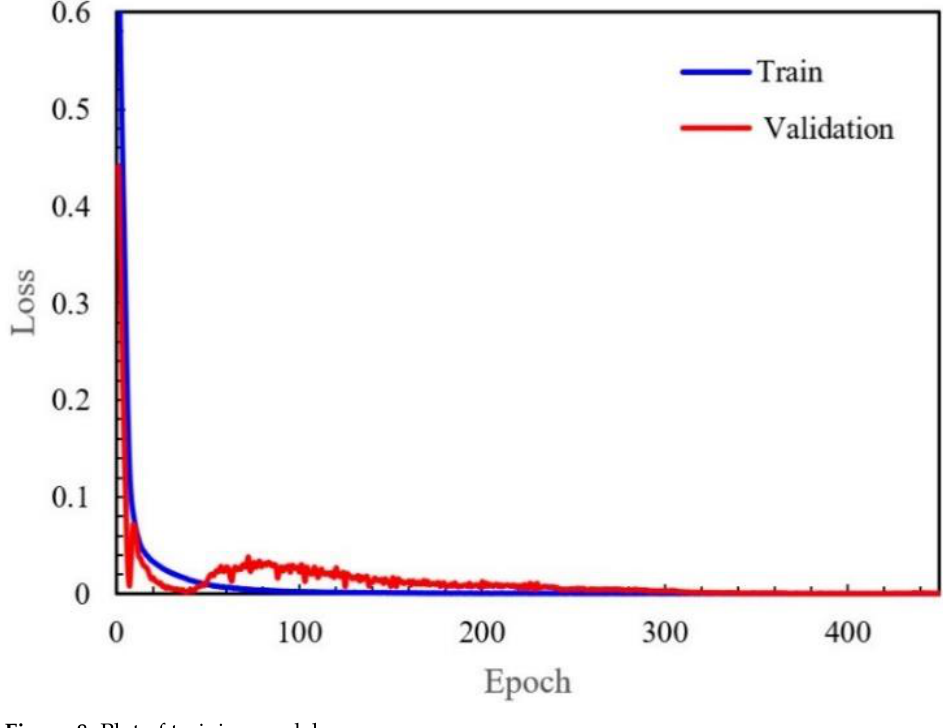
Figure 7. Regression plot of experimental versus tested viscosity.